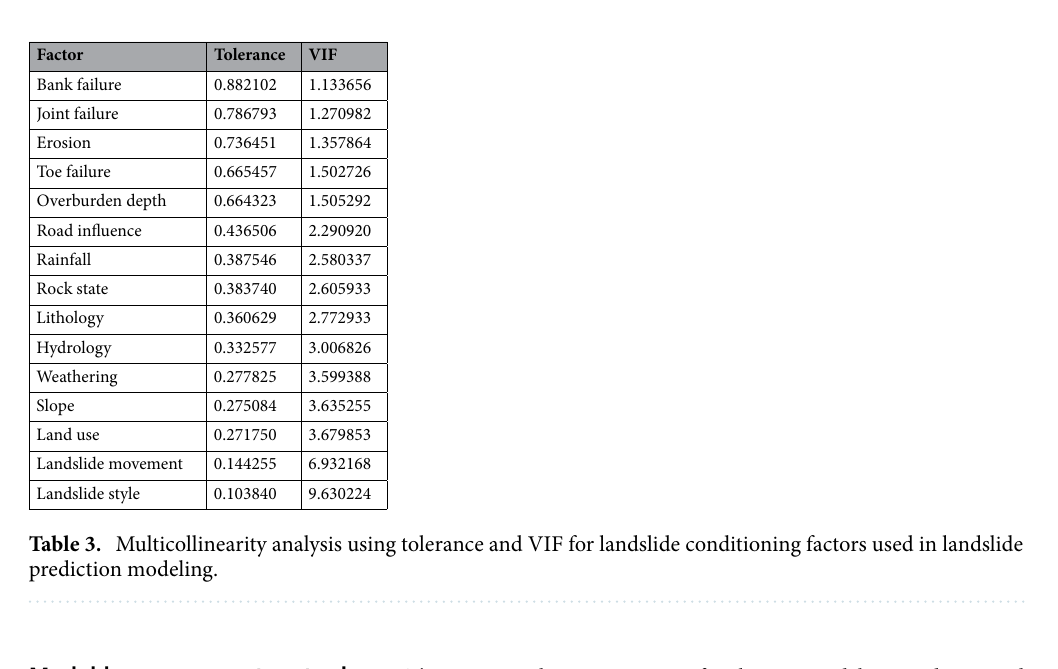
Figure 5. Significance of total 15 landslide conditioning factors using LASSO feature selection technique.